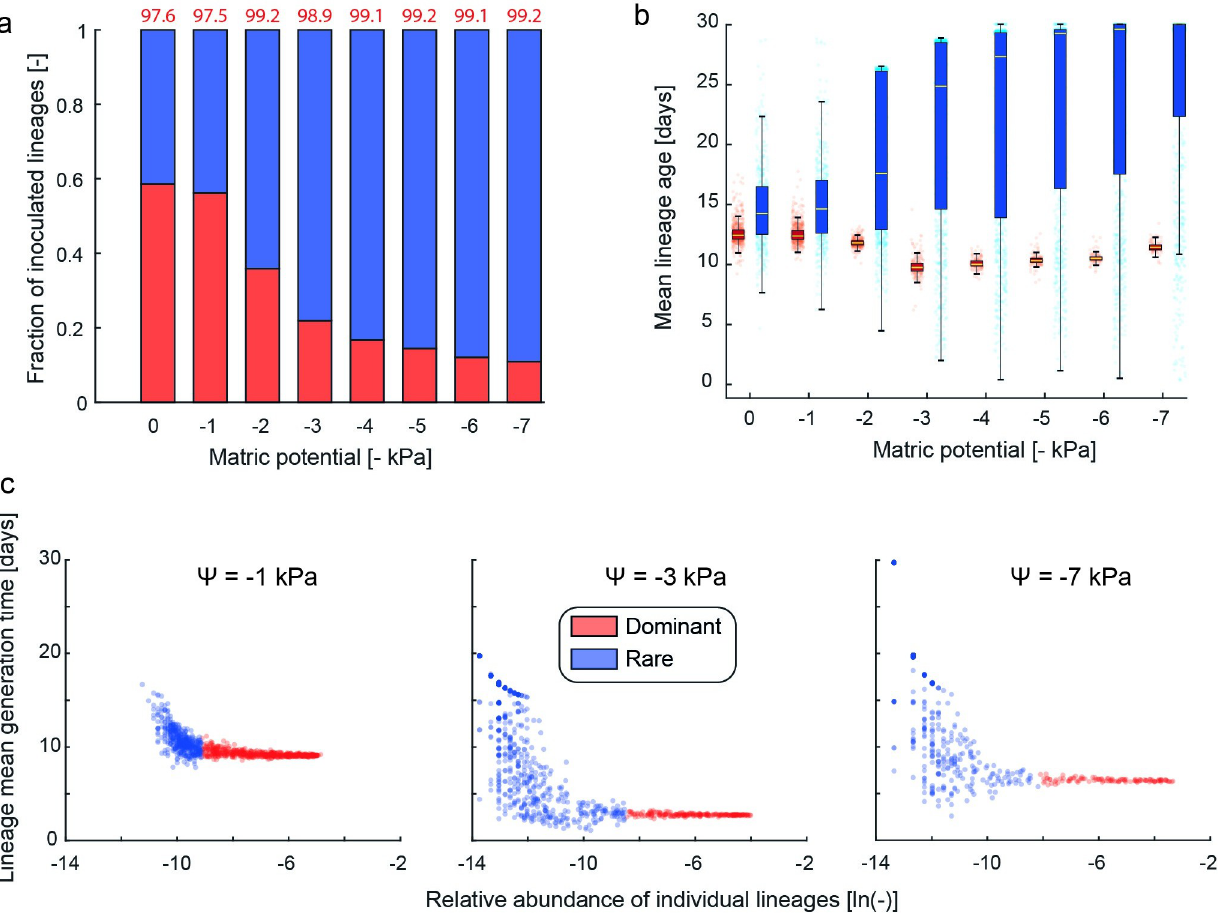
Fig 4. Characteristics of dominant (highest reproductive success) and rare lineages vary with hydration conditions. a) Percentage of lineages from the inoculum classified as dominant and rare. With a decline in bacterial motility towards drier conditions, most inoculated lineages cannot proliferate and contribute to the rare fraction of the community. Above numbers (in red) report the contribution (in percentage) of the dominant lineages to the final community biomass. b) Mean lineage cell age depending on their classification into rare and dominant shows an overall older cell population for the rare fraction due to their lower reproductive success. c) Mean lineage generation time in relation to their relative abundance (log) for three hydration conditions. The rare fraction is typically associated with longer mean generation times and only occurs in drier conditions where aqueous nutrient diffusion is limited to thin water films and capillary pinning forces immobilize bacterial